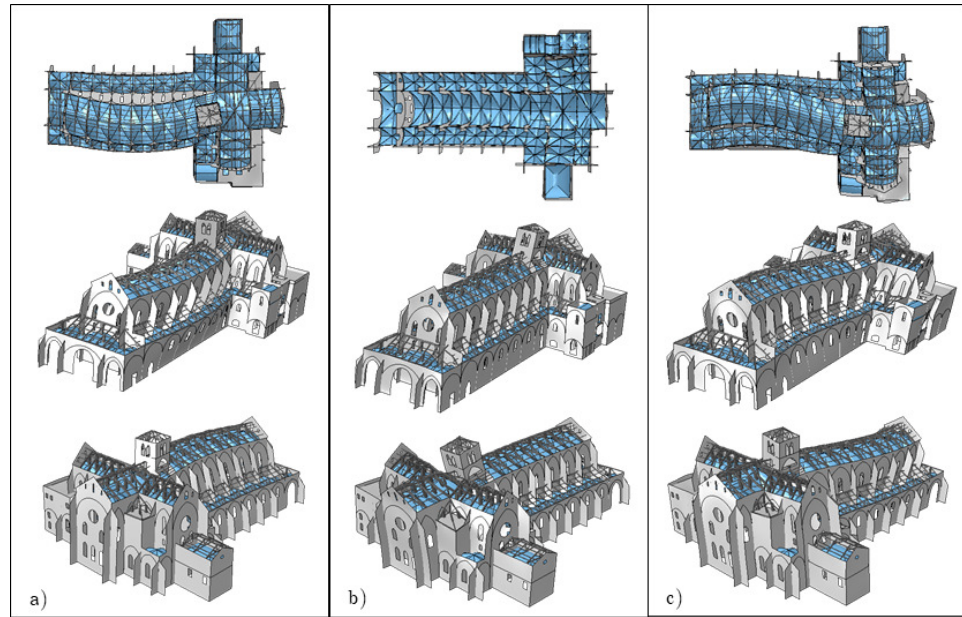
Figure 6. ( a ) First, ( b ) second and ( c ) third modal shapes. Table 2. Modal frequencies and partecipating